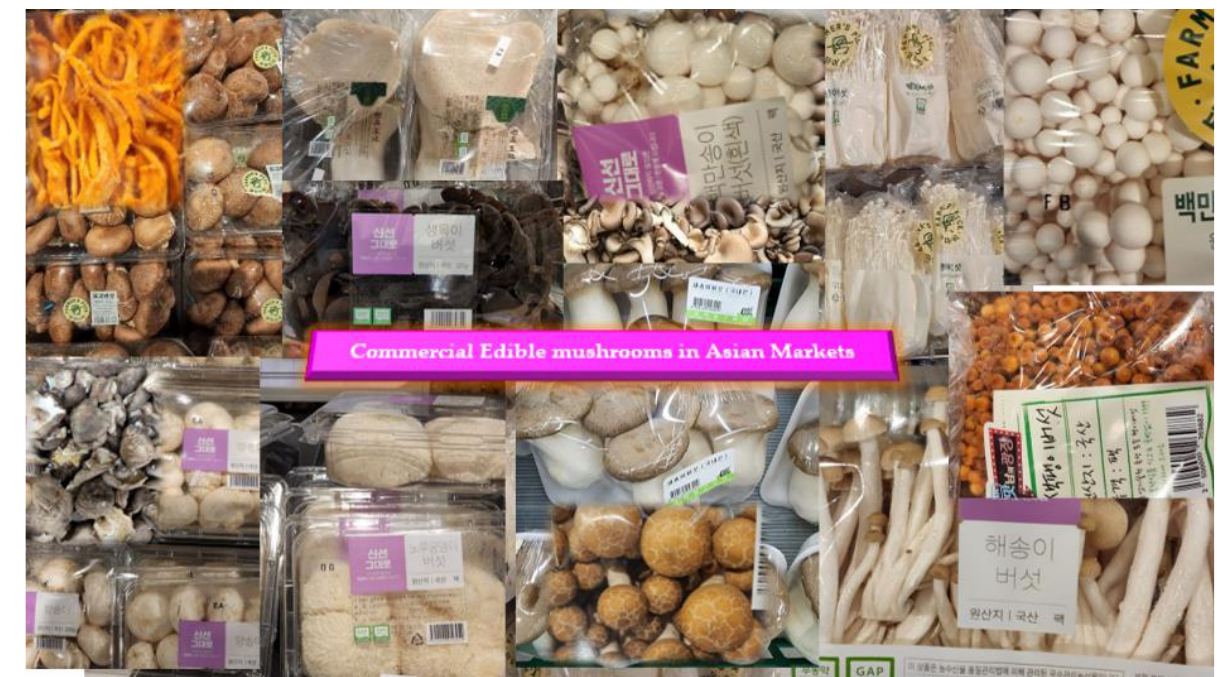
Figure 1. Overview of the various edible mushroom varieties in the Korean market. With wheat, rice and maize being the staple food of a vast majority of the global population, there is a marked deficit of protein in our diets. Supplementation of mushrooms bridges the protein gap and improves nutrition and wellbeing of socially and economically backward communities. In the past, mushrooms were categorized as expensive/exotic vegetable types, and consumed only by the elite. Nowadays, thanks to the increasing awareness, these are made available through local mushroom farmers to the general public. Mushrooms hold holistic nutrition, suitable for all age groups. The nutritional value of mushrooms is strongly influenced with respect to the species, stage of development and environmental conditions. Mushrooms contain surplus protein, dietary fiber, vitamins and minerals, as well as starches, pentoses, hexoses, disaccharides, amino sugars, sugar alcohols and sugar acids. The carbohydrate content of mushrooms ranges from 26 to 82%. Their crude fiber is made up of partially digestible polysaccharides and chitin. Mushrooms commonly have low lipid levels, yet they contain polyunsaturated fatty acids in large proportions. Thus, they have low calorific yields and no cholesterol. They also contain ergosterol (Vit-D precursor), proving to be highly advantageous [1,8–11]. Figure 2 shows a few representative chemical structures of bioactive moieties in edible mushrooms. Shiitake is a famous mushroom variety that contains eight essential amino acids, as well as linoleic acid. Shiitake when consumed can enhance satiety, which is ideal for weight loss. In addition, they also are abundant in phytonutrients, which are responsible for health and immune function. Porcini mushrooms add unique flavor to broths, and are incorporated into bread or pasta flour. These mushrooms are rich in antioxidants, beta- carotene, ascorbic acid and lycopene and fiber and plant-based protein. Chaga has an earthy flavor, and it contains vanillin; it is the best food when it comes to oxygen radical absorbent capacity, implying its potential to become a rich source of antioxidants and help in disease prevention. Chaga mushrooms reduce inflammation and improve physical endurance. Lion’s mane has brain-boosting properties, fighting Alzheimer’s. It also is ideal fort he heart and digestive health because of its anti-inflammatory potential. Reishi mushrooms have been valued by Chinese populations for thousands of years. They go by the nickname “king of mushrooms” and prompt the body to tackle negative effects of stress. They are a rich reservoir of antioxidants and health-promoting polysaccharides. Reishi mushrooms balance hormones, promote heart health and stabilize blood sugar levels. Cordyceps are